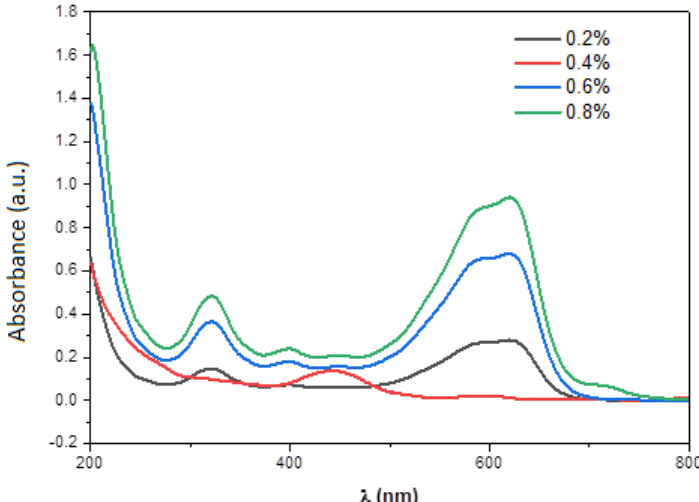
Figure 11 . UV − Visible spectra of BA-dye for different volume concentration (0.2% 0.4% 0.6%, and 0.8%).